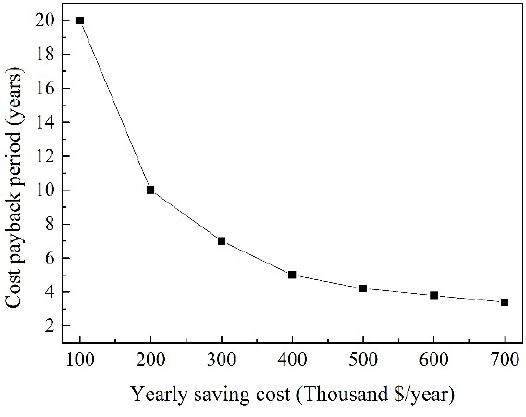
Figure 12. Relationship between cost payback period and yearly saving cost with a scrubber.